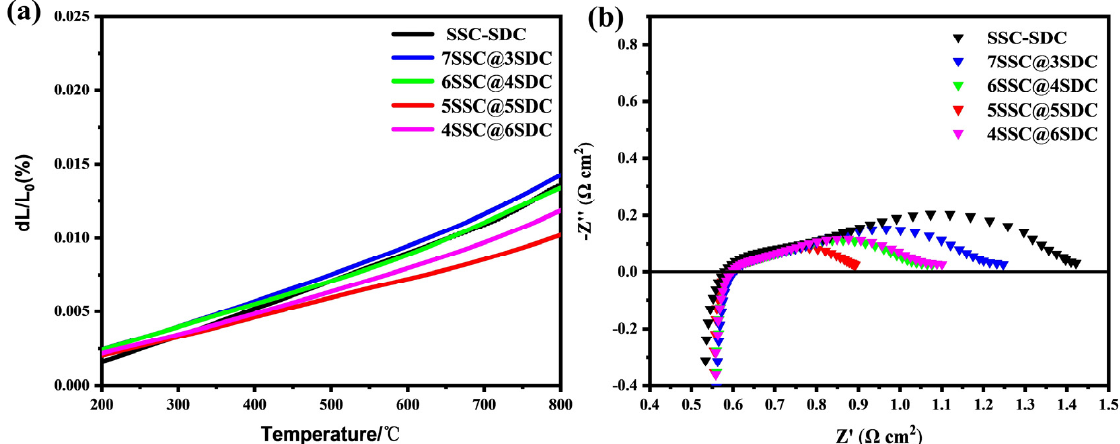
Figure 5. ( a ) TEC curves for SSC-SDC, 7SSC@3SDC, 6SDC@4SDC, 5SSC@5SDC, and 4SSC@6SDC samples. ( b ) EIS curves of the symmetric cells with SSC-SDC, 7SSC@3SDC, 6SDC@4SDC, 5SSC@5SDC, and 4SSC@6SDC electrodes measured at 800 ◦ Table 1. Specific average TEC values for SSC-SDC, 7SSC@3SDC, 6SSC@4SDC, 5SSC@5SDC, 4SSC@6SDC composites between 200 and 800 °C in air.